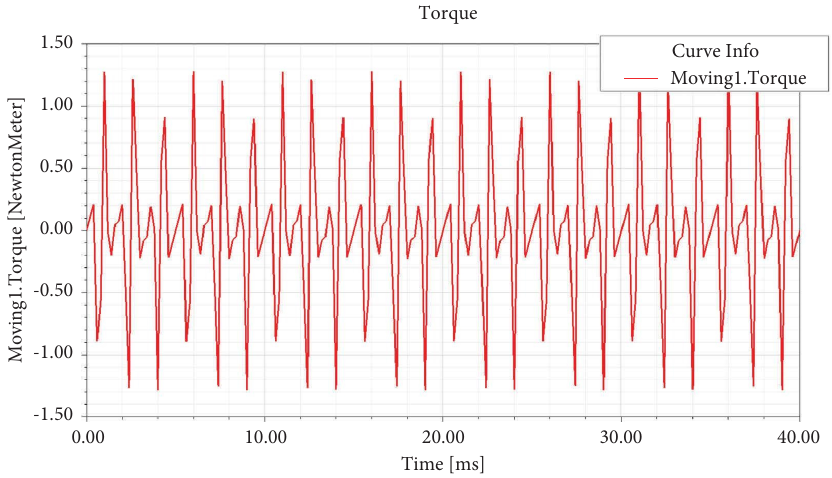
Figure 30: Magnetic resistance torque curve of fat-bottom ladder slot motor.